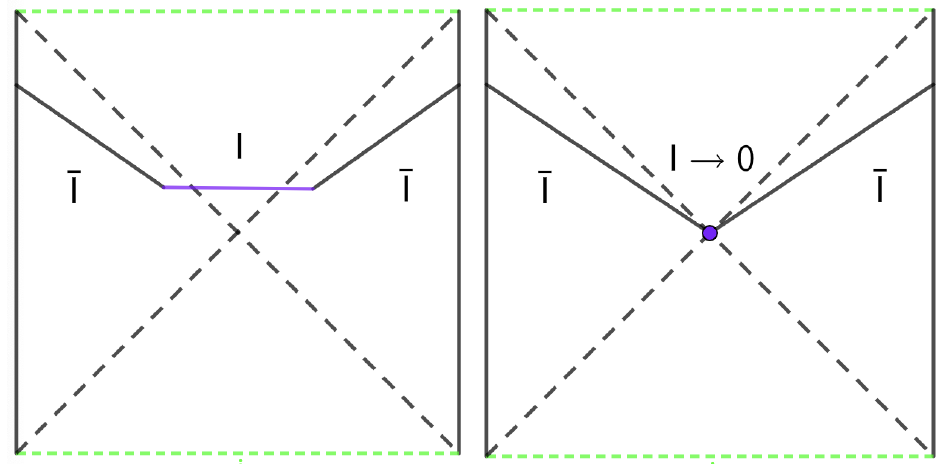
Figure 3 . Left: Penrose diagram on brane Q in the usual double holography (figure 1). Right: Penrose diagram on the strong-gravity brane Q 2 in wedge holography (figure 2). The black-dotted line, green-dotted line, and the purple line or point denote the horizon, singularity and island, re- spectively. It shows that the island shrinks into a point in the Penrose diagram of wedge holography. In this sense, it claims that the entanglement island disappears in wedge